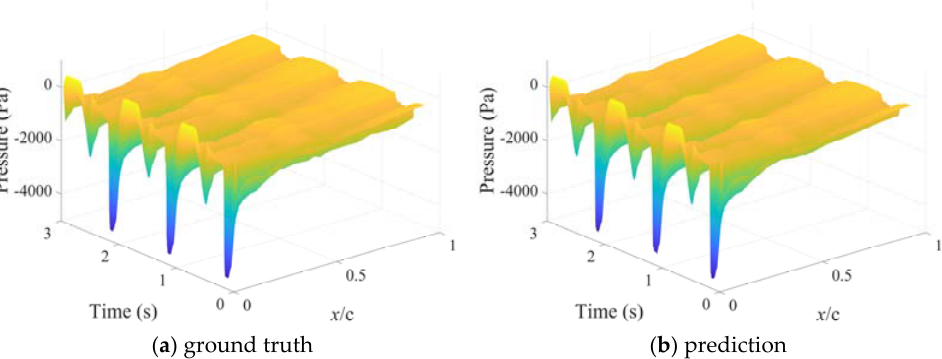
Figure 8. Pressure field on the upper surface of the oscillating airfoil: ( a ) ground-truth data from pressure sensors, ( b ) reconstruction using DMD with time-delay embedding.